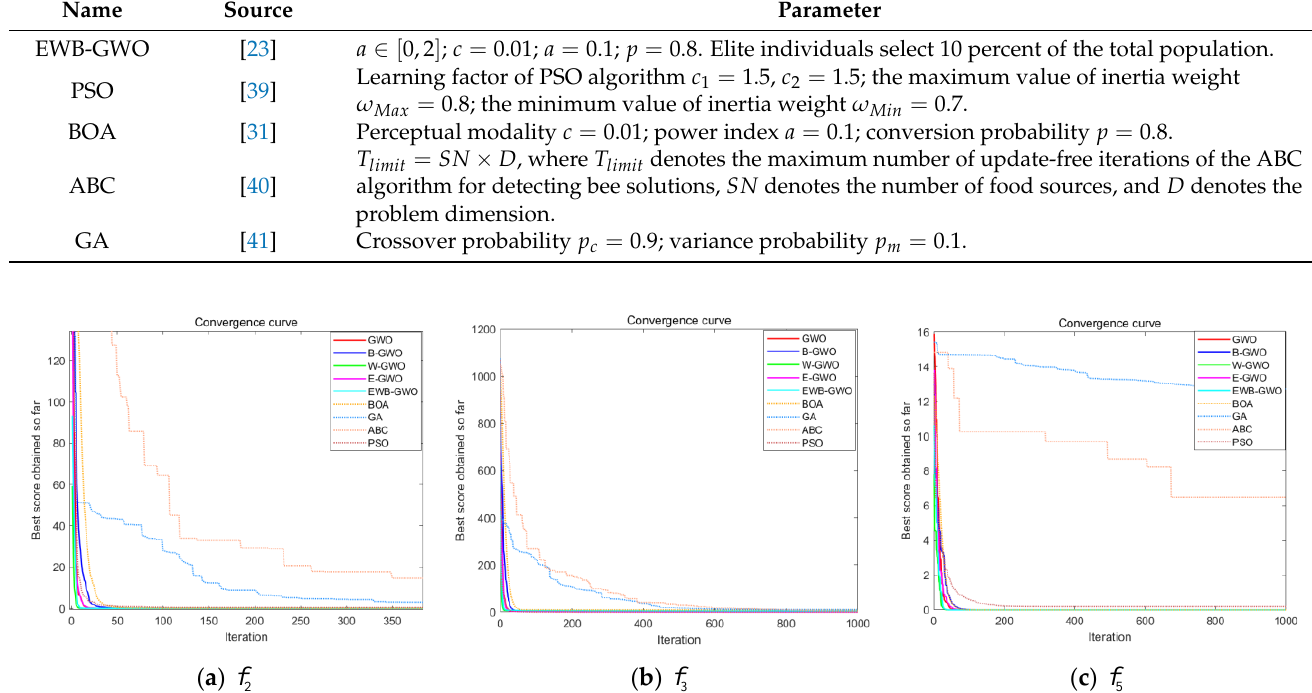
Table 6. The parameter setting of each algorithm.